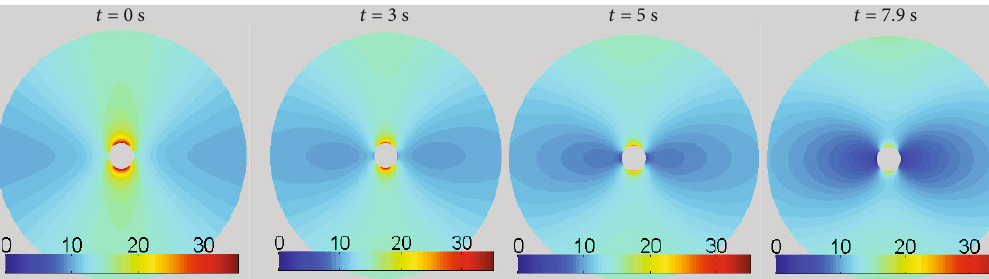
Figure 5: Wellbore breakdown process for the case of wellbore fl uid fl owing into rock and accounting seepage